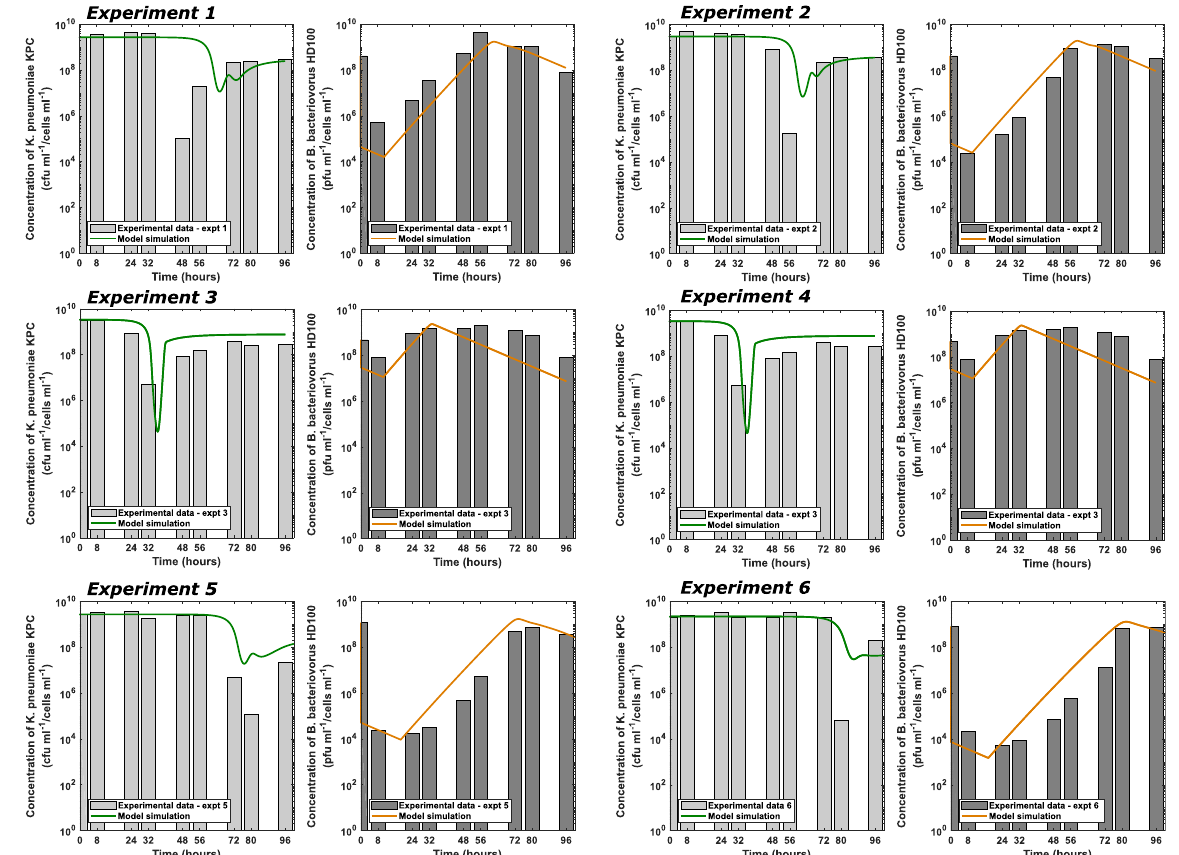
Figure 9. Model simulations of predation of K. pneumoniae by B. bacteriovorus in human serum, with varying levels delayed successful attachment, allows the model to fit each independent experiment (see Fig. 5 for experimental results).The delayed attachment parameter values for each experiment are k 1early = [1.433 × 10 − 14 ;